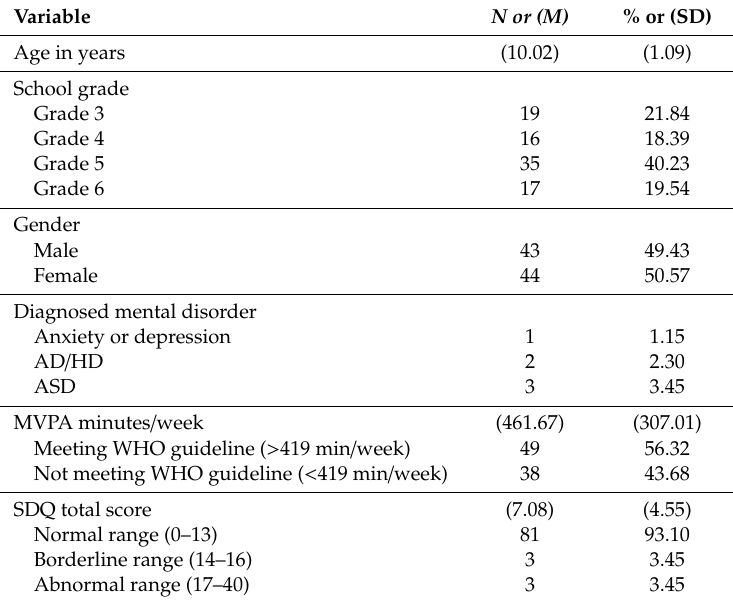
Table 1. Participant characteristics and descriptive statistics.